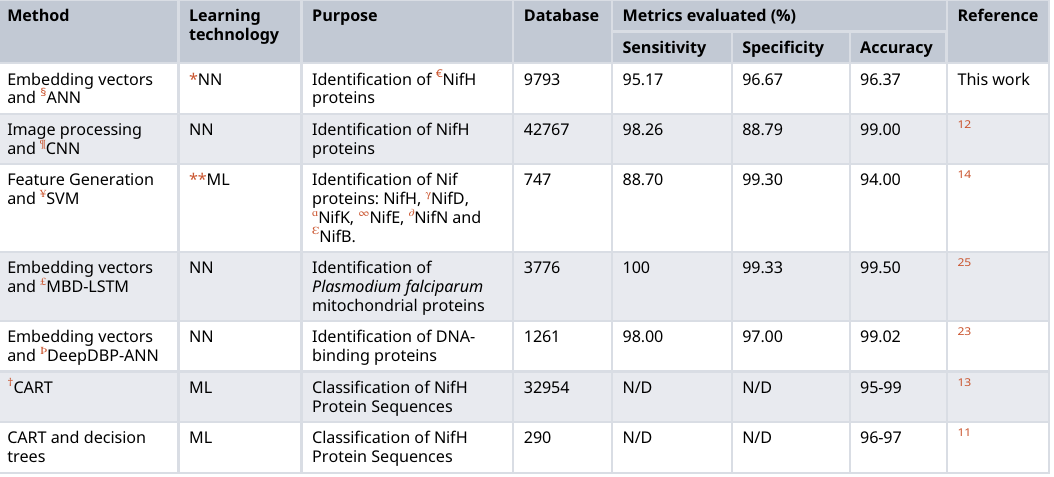
Table 3. Performance of our model in comparisons with other methods of machine learning. Method Learning technology